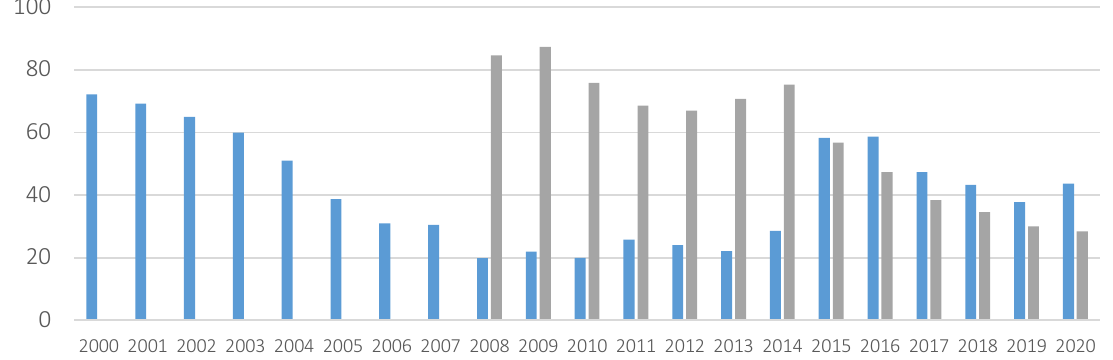
Figure 4. Poverty level and domestic credit to the private sector in Ukraine in 2000–2020,